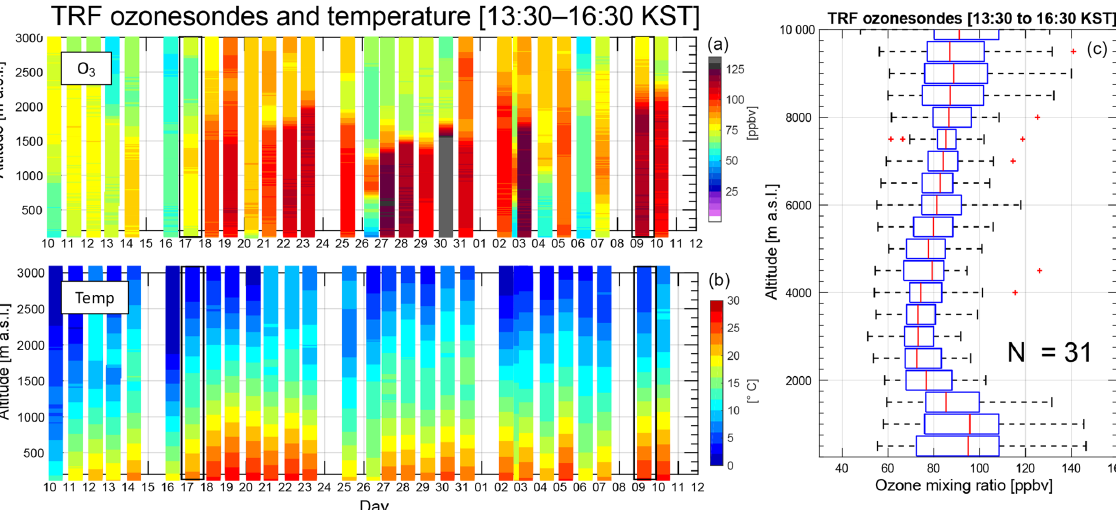
Figure 4. Afternoon soundings (13:30 to 16:30KST) of O 3 ( a , from ECC O 3 ozonesondes) and temperature ( b , from concurrent radiosondes) and a box-and-whisker plot (c) illustrate day-to-day variability at TRF. The two case studies (17 May and 9 June) are highlighted with black